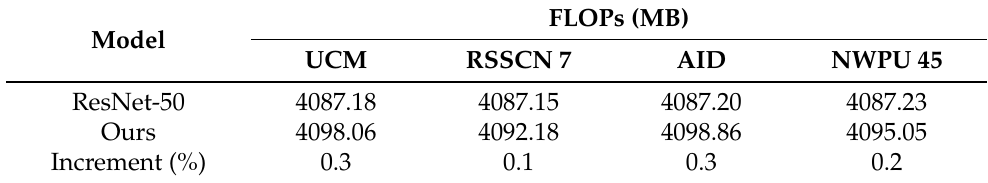
Table 2. Comparison of the FLOPs of the models before and after improvement.